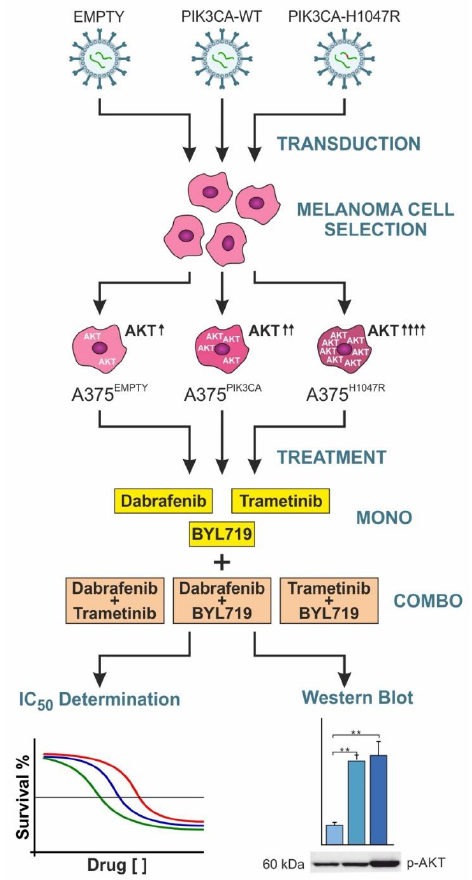
Figure 1. Experimental workflow of the study.